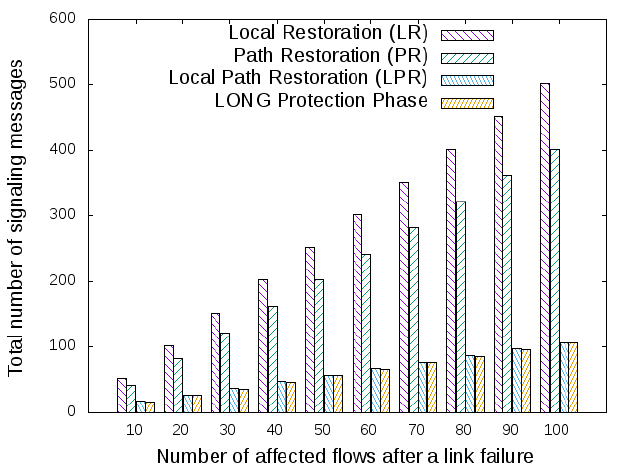
Figure 7. Results for the signaling overhead after a link failure in different scenarios of the Abilene